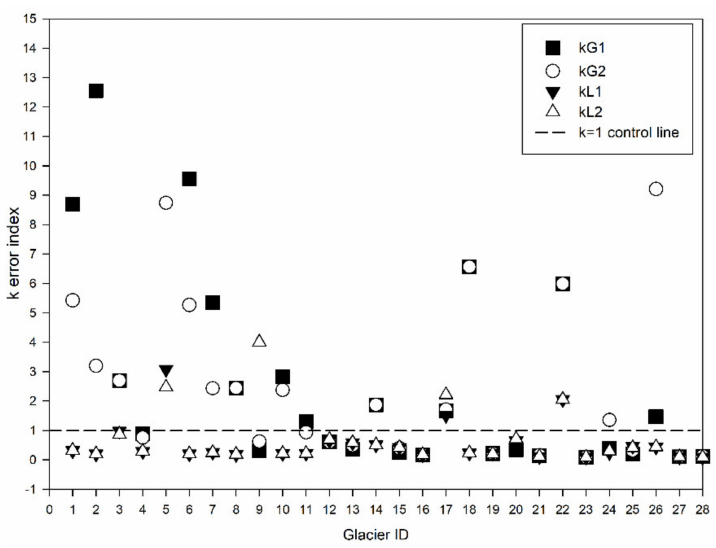
Figure 6. Error index calculated for each interpolation method used. Note that the glaciers have been assigned IDs in an increasing order as a function of their mean